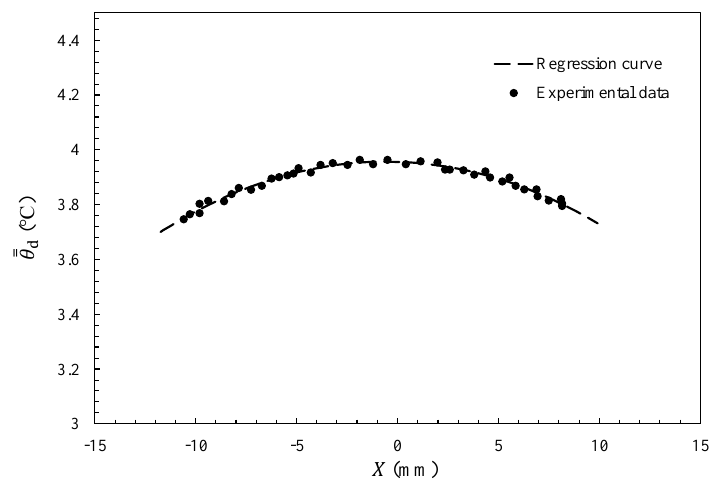
Figure 10. One-dimensional distribution of the average temperature shift and the double exponential regression